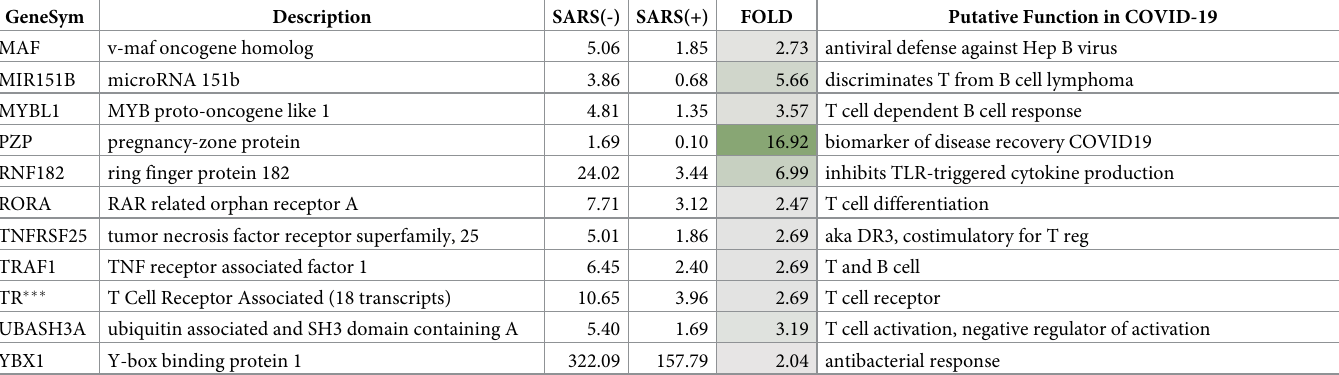
showing stepwise increases from 6.37% of actin B (%ACTB) in normal controls, to 19.7% in Incidental COVIDs, 62.5% in Moderate COVIDs, and 86.2% in Critical COVIDs (Fig 3, lower left panel). ALPL and IL8RB RNA levels, which we have shown are related to biofilm-type infections, such as appendicitis, also showed detectable increases. While expressed at overall lower absolute values than DEFA1, myeloperoxidase (MPO) and resistin (RSTN) RNAs showed strong and significant changes in the COVID-19 patients (Fig 3, lower right panels). The DEFA1 score in whole blood was modestly correlated with the Sequential Organ Fail- ure Assessment (SOFA) score as an indicator of COVID-19 severity (Pearson R = 0.45, Fig 4). The SOFA score estimates the severity and number of organ systems involved in the disease. This analysis identified 3 patients with low to medium SOFA scores (6–11 on a scale of 24) that had apparently normal DEFA1 scores ( < 10%) that were classified as ‘Critical’. However, their viremia was at or below the threshold of detection of N1 or N2 spike protein transcripts by ddPCR, suggesting their illness may originate from non-SARS causes. Further, 2 of the 3 patients had elevated ‘biofilm’ biomarkers (APLP+IL8RB) suggesting they had non-SARS-- CoV2 co-infections. The APACHE2 score was also positively, but slightly less correlated to DEFA1 score (Pearson R = 0.31, not